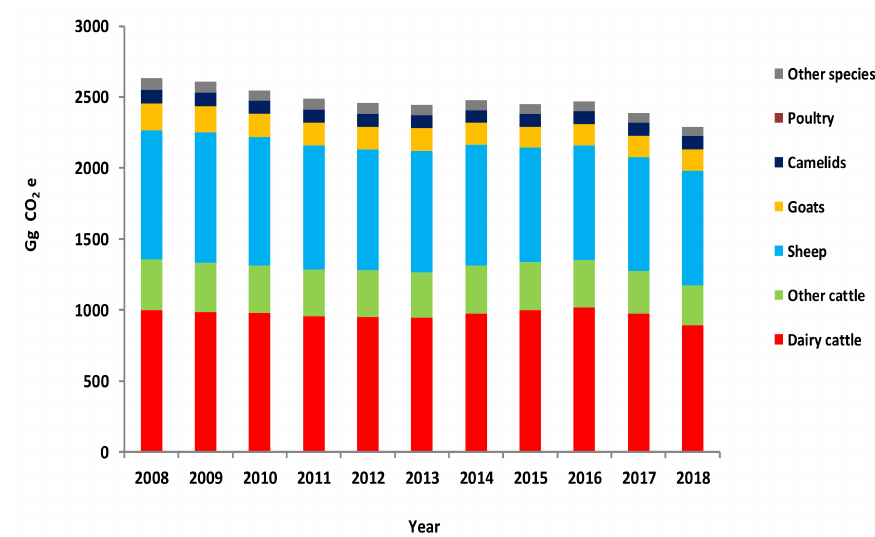
Figure 5. Evolution of CH 4 emissions (Gg CO 2 e) issued from the enteric fermentation by the di ff erent animal species / category from Tunisian livestock during the studied period (2008–2018).